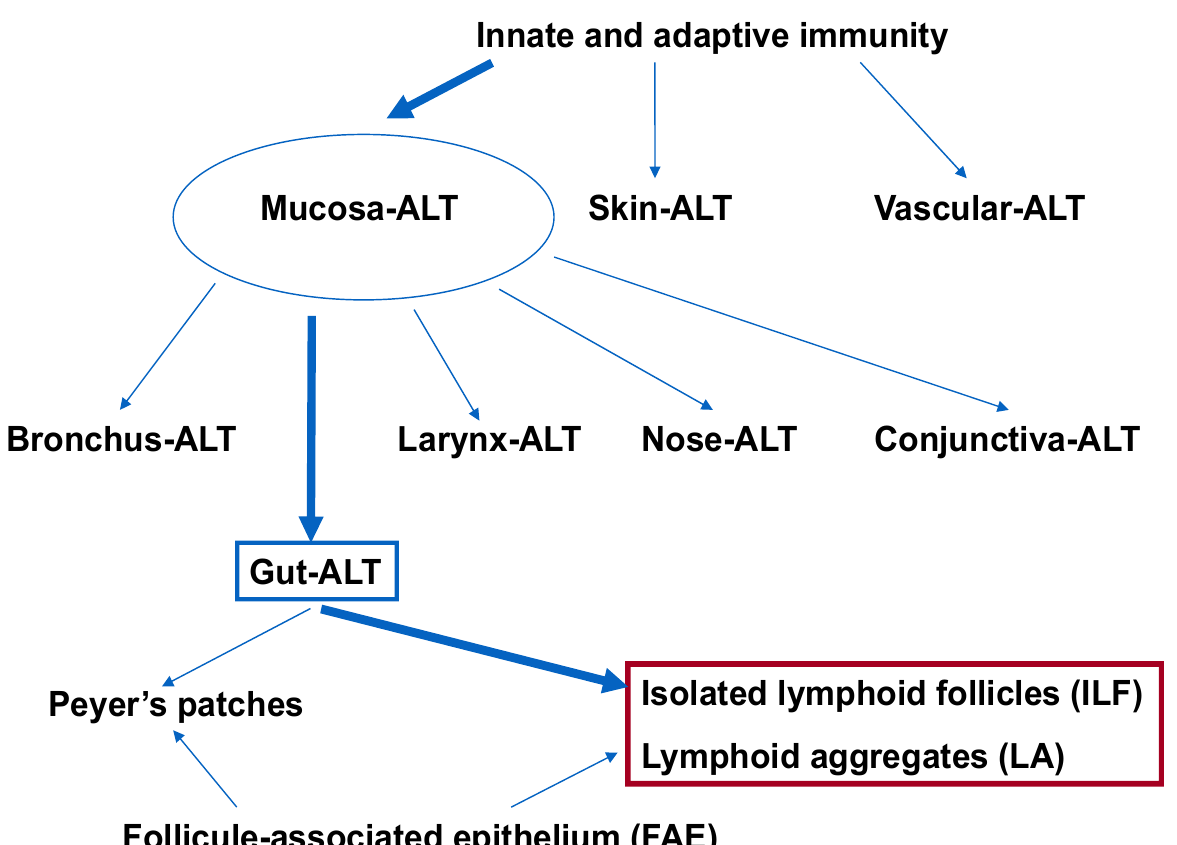
Figure 1. Organization of the gastrointestinal lymphoid tissue: Nearly 70% of innate and adaptive immune cells are found in mucosal-associated lymphoid tissue. In addition to MALT, SALT and VALT also exist. One part of MALT is GALT, whose major lymphoid organs are PPs, ILFs, and Las; each has an FAE with a distinctive structure and function. The highlighted components refer to the colon. ALT: associated lymphoid tissue.